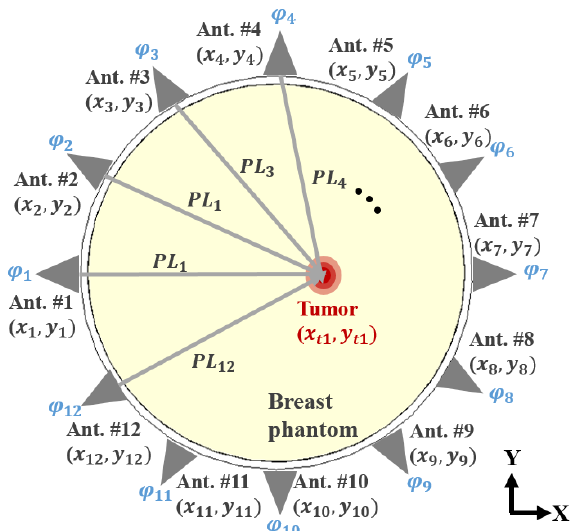
Figure 5. The EM waves focusing on the breast phantom with different path lengths from TSA antennas.